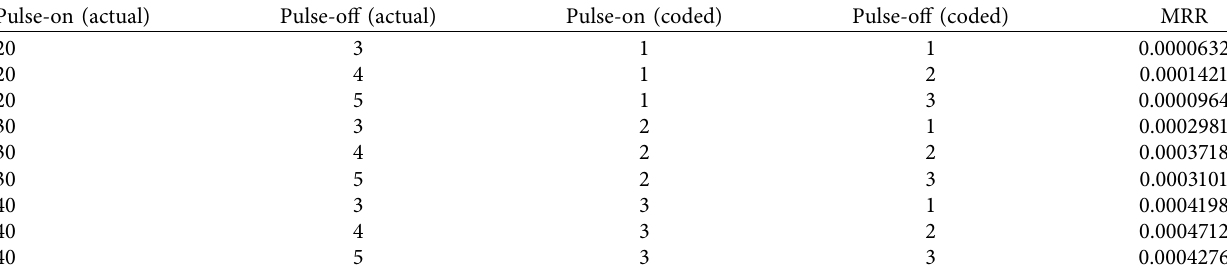
Table 7: MRR values for mild steel.